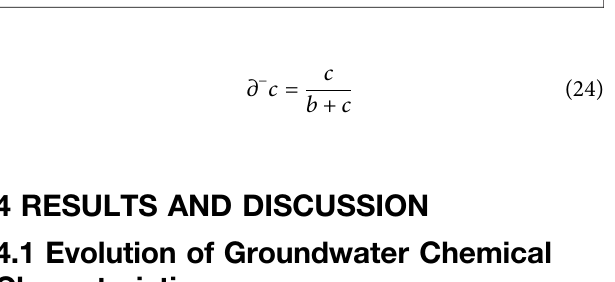
FIGURE 3 | The Piper trilinear diagram of conventional ions of the shallow groundwater in different